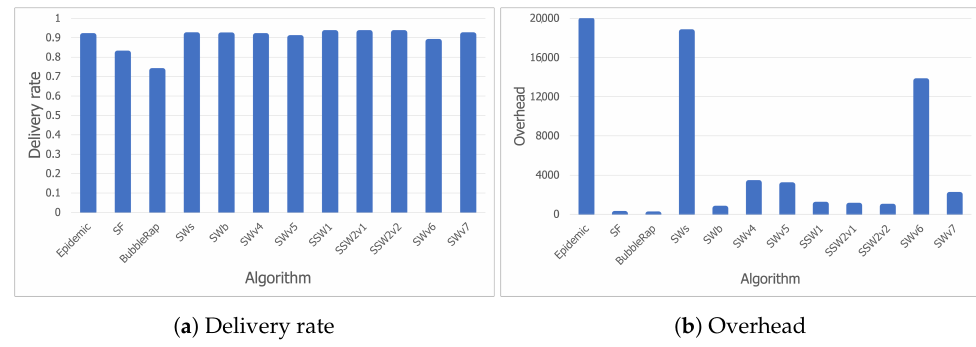
Figure 8. Delivery rate and overhead for the Bluetooth trace.